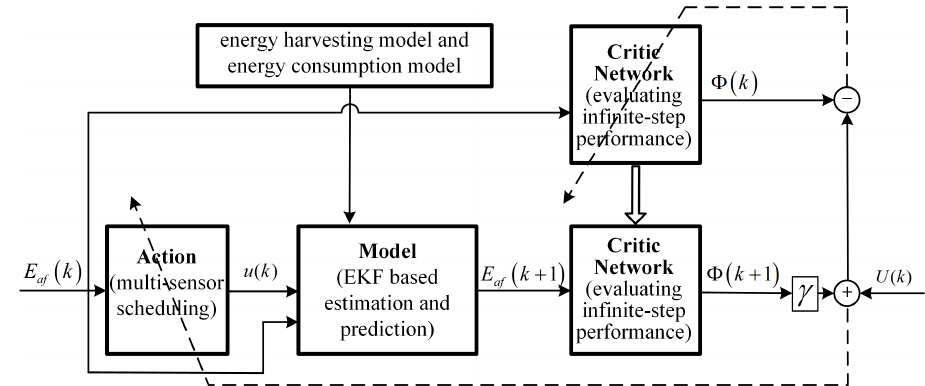
Figure 2. Structure of the adaptive dynamic programming based multi-sensor scheduling algorithm (ADP-MSS). EKF: extended Kalman filter.